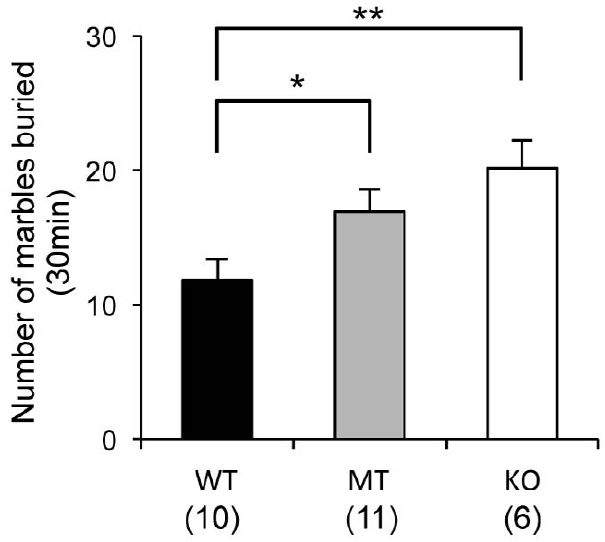
Figure 5. Marble burying test. Usp46 MT and KO mice buried significantly higher number of marbles than WT mice did. The number of mice used is shown within parentheses. One-way ANOVA with Fisher’s PLSD test; * P , 0.05, ** P , 0.01.